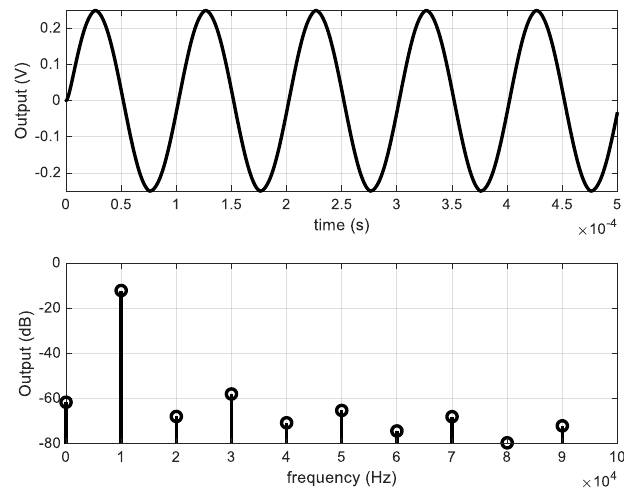
Figure 8. Sinusoidal response in time ( top ) and frequency ( bottom ).